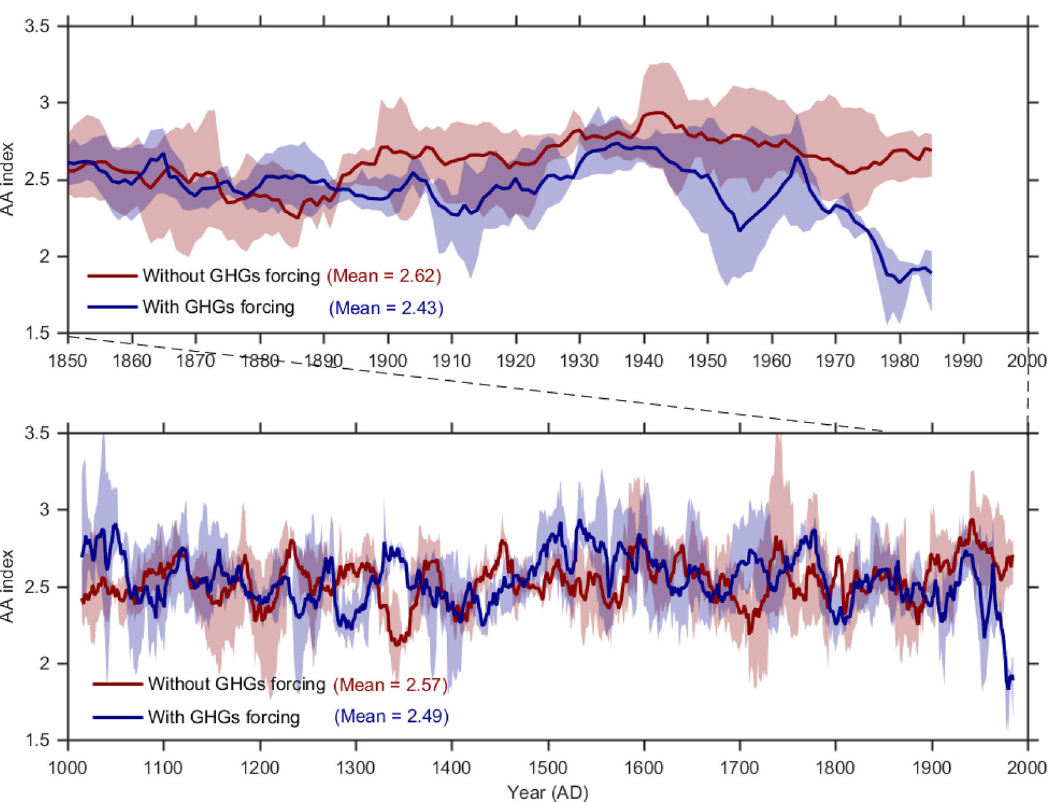
Fig. 5 Variations of the AA indices without GHGs forcing and with GHGs forcing during the past millennium and the industrial era. The dark red line represents the ensemble mean of a three-member ensemble of climate model simulations driven with orbital forcing only. The dark blue line represents the ensemble mean of a three-member ensemble of climate model simulations driven with both orbital forcing and GHGs forcing. Light red and light blue shadings are minimum and maximum of the ensemble. The model simulations were provided by long-term ensemble simulation experiments 38